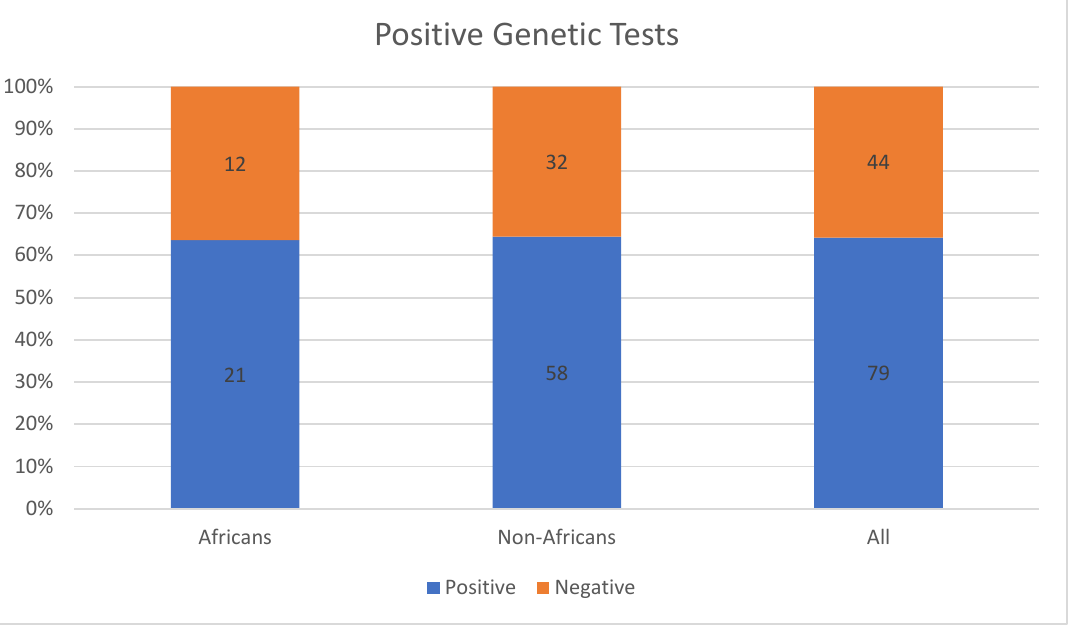
Figure 2. Proportions of positive genetic tests for IRDs among Africans and non-Africans in the study by Maltese et al. [15].